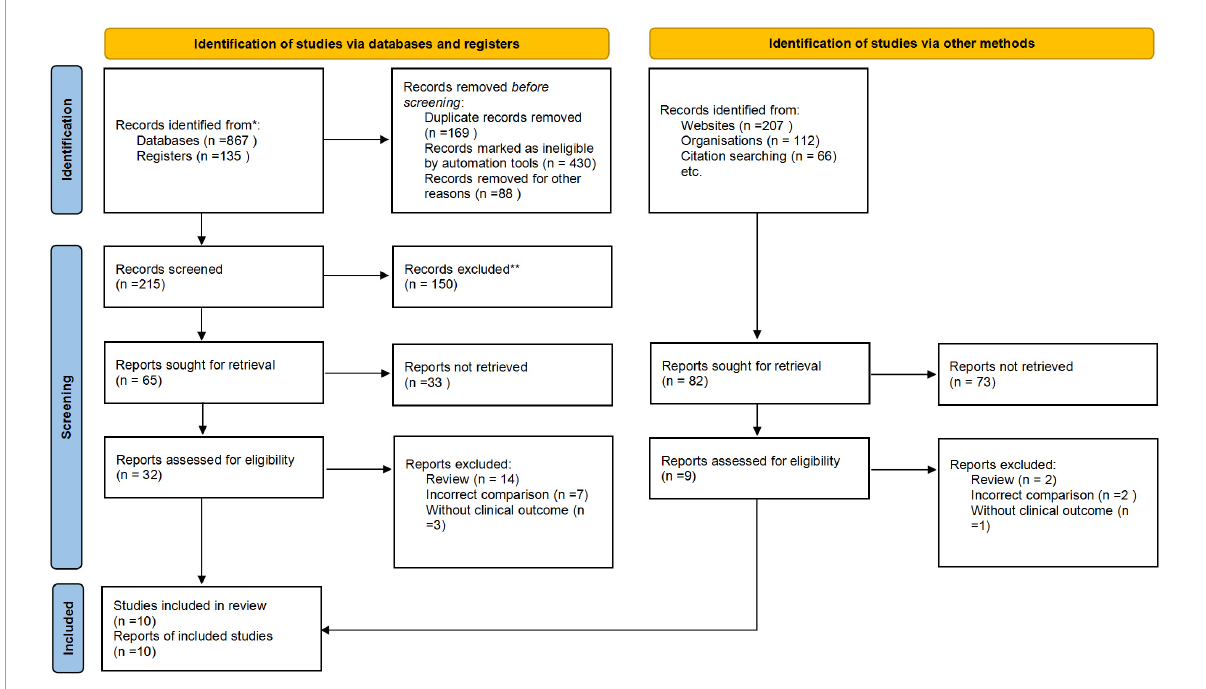
FIGURE1 Sensitivity analysis of the impact of SPN and EN nutritional support treatment on all-cause